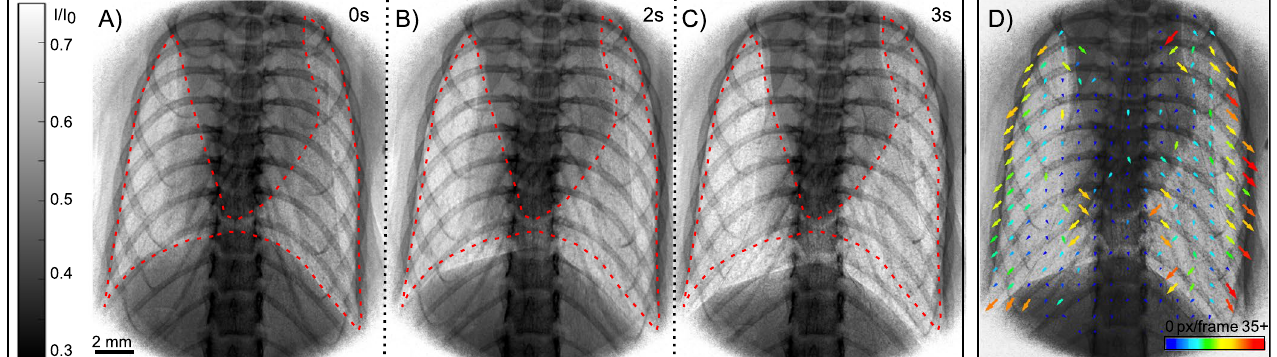
Figure 2. The motion of murine lungs during a slow breath cycle is imaged in vivo using propagation-based X-ray phase-contrast imaging. The red dotted outline, fixed at the start of the breath, highlights the changes in the shape of the lung during inhalation. Panels (A–C) show the first 3 s of the whole breath cycle (8 s). The expansion of the lung and increase in image intensity during inhalation is clearly visible. Supplementary Video S1 shows several breaths, captured with 15 images per breath. Panel (D) shows the corresponding X-ray velocimetry map during inhalation. As predicted, the largest movement is located at the lung periphery, as indicated by the warm end of the spectrum colour map used to display vector length. The maximum displacement vector length in (D) is 56